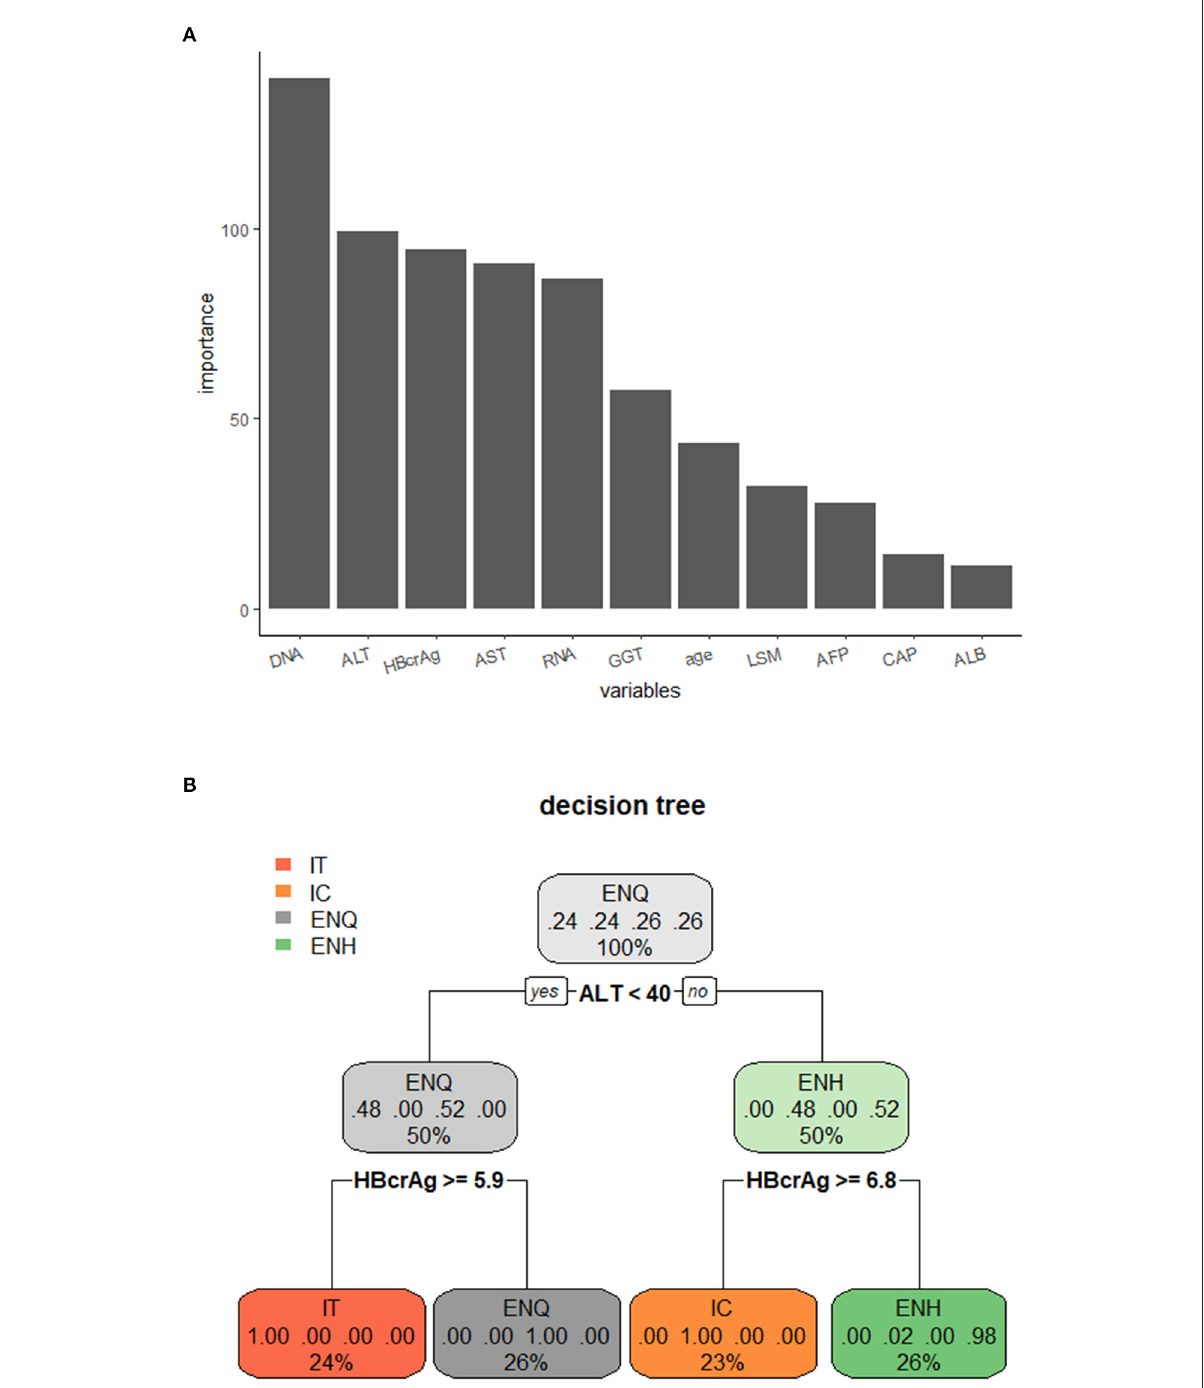
FIGURE4 Decision tree model for distinguishing the phases of the natural course of CHB infection. (A) Importance of the variables in the decision tree model. (B) Decision tree model for distinguishing the phases of the natural course of CHB infection using ALT combined with HBcrAg. IT, immune tolerance; IC, immune clearance; ENQ, hepatitis B e antigen-negative inactive/quiescent carrier phase; ENH, hepatitis B e antigen-negative